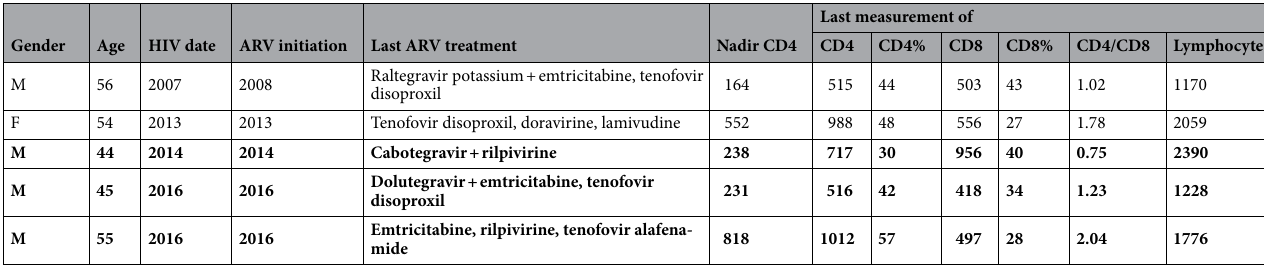
Table 3. Patient data from the HIV reservoir follow-up study. The three values shown in the table with bold values are the positive